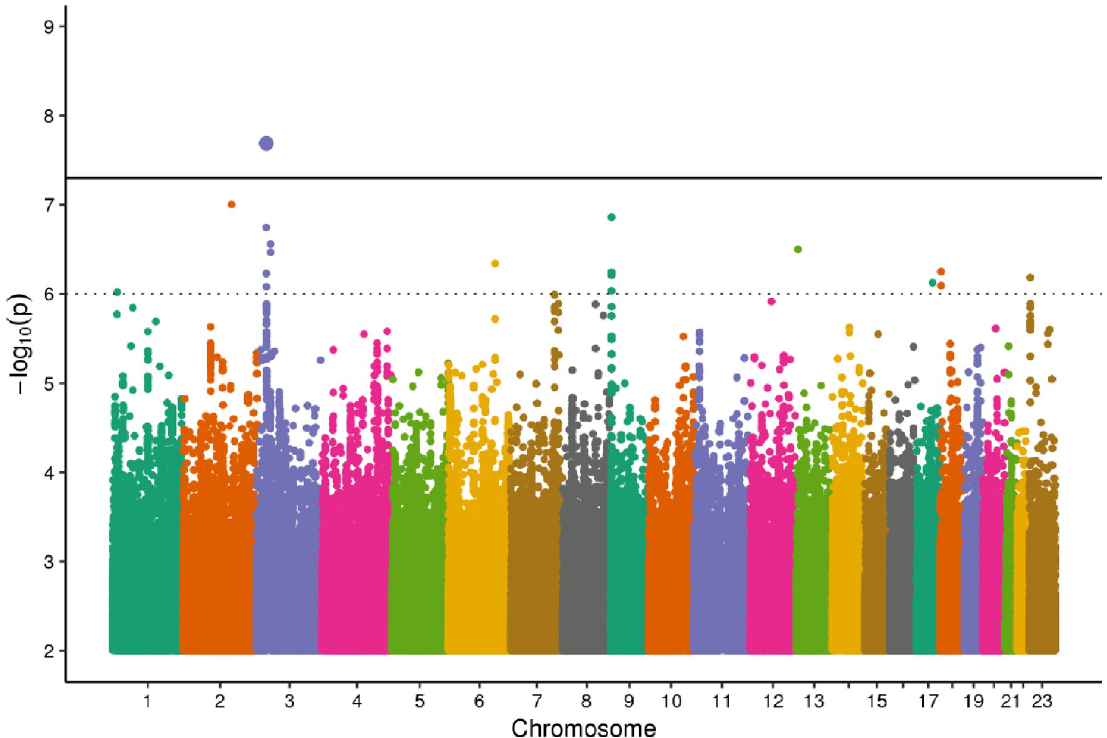
Fig 2. Manhattan plot. Distribution of minimal log10 transformed p-values for all three phenotypes. The bold line marks genome-wide significance (p < 5x10 -8 ). Top SNP rs939834 (Cytoband 3p24.1, phenotype cfPWV) is supported by three SNPs with suggestive significance level (dotted line) in the same